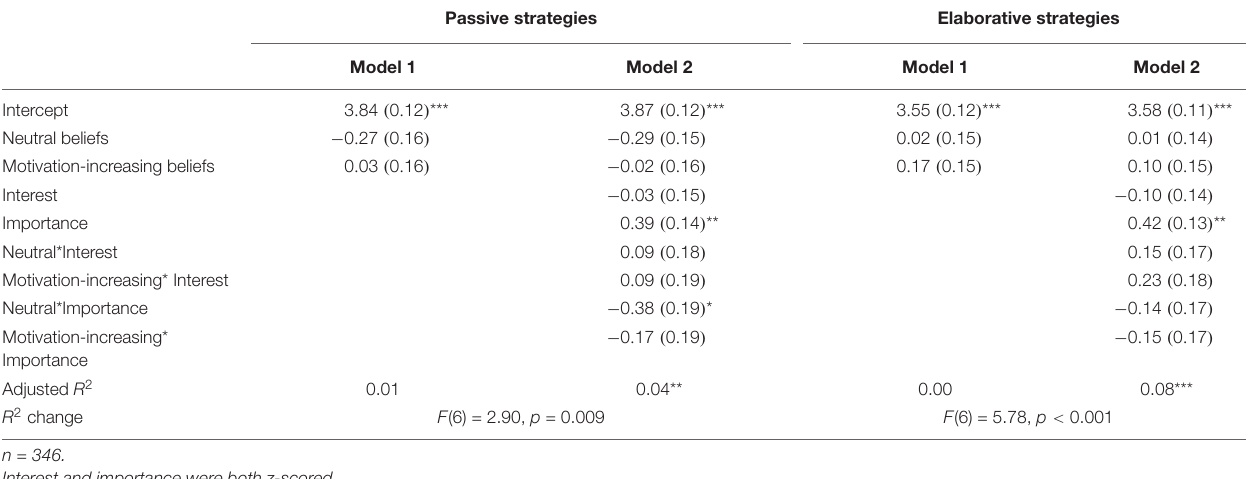
TABLE 6 | Summary of regression coefficients, predicting study strategy use from implicit belief profiles, course interest, and course importance.